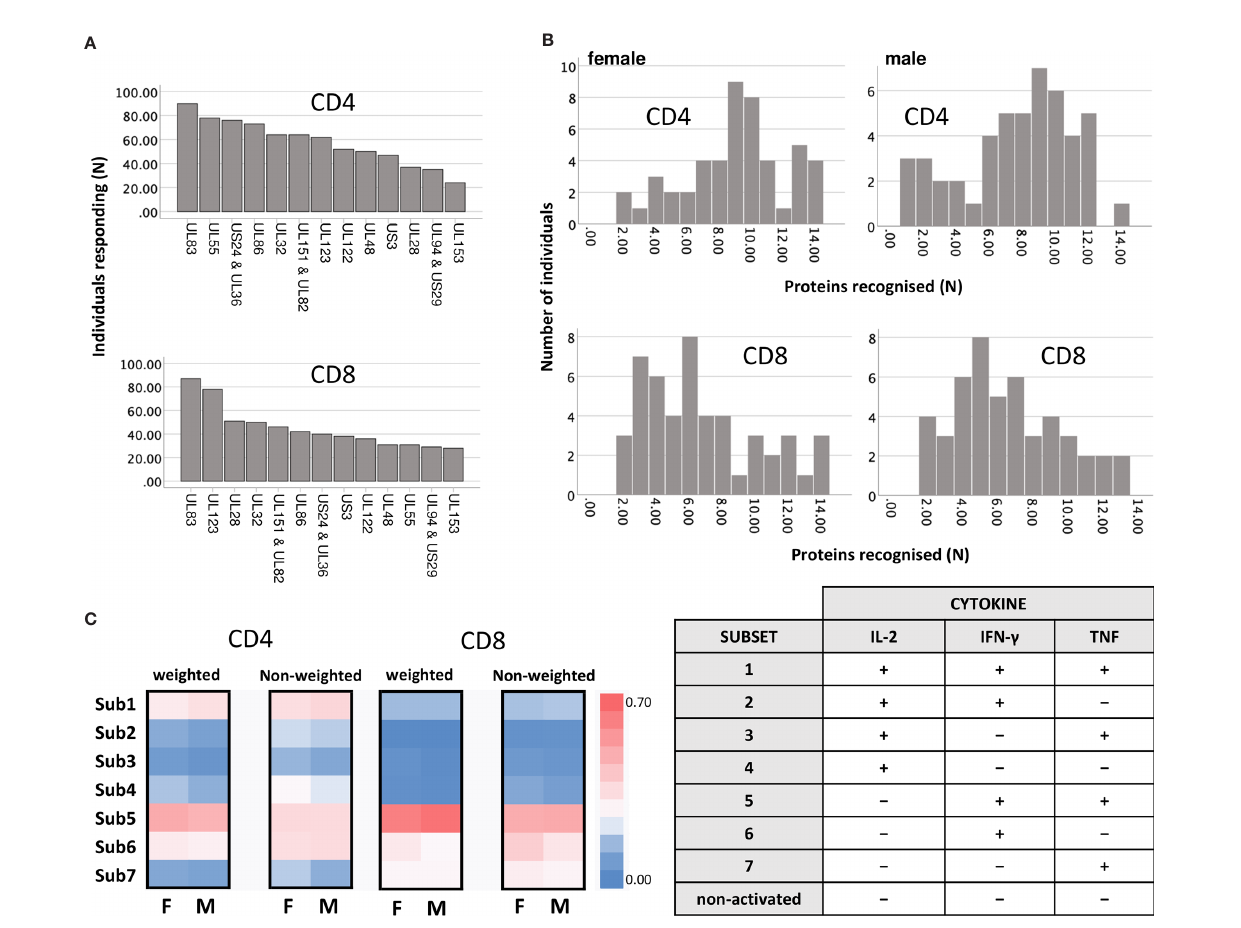
FIGURE 1 | Reactivity of CD4 and CD8 T-cells against dominant CMV proteins. (A) The indicated proteins (overlapping peptide pools) were used for PBMC stimulation. Responses (IL-2, TNF, or IFN- g ) equal to or higher than 0.01% (1/10,000) of the reference population (CD4 or CD8) were included. The graph shows the number of individuals recognising the indicated CMV protein pools within the entire cohort (n=94). (B) The graph shows the number of recognised proteins per individual (x-axis) in females (right panels, n=47) and males (left panels, n=47), respectively. (C) Heatmaps show the frequency distribution of functional Subsets 1 to 7 (respectively: IL-2+/TNF+/IFN- g +; IL-2+/TNF+/IFN- g -; IL-2+/TNF-/IFN- g +; IL-2+/TNF-/IFN- g -; IL-2-/TNF+/IFN- g +; IL-2-/TNF+/IFN- g -; and IL-2-/TNF-/IFN- g +, right table) within CD4 and CD8 T-cells, in females and in males. The heatmaps on the left show the contribution of each subset after weighing this relatively to the overall response size, while the heatmaps on the right show the unweighted contribution (not normalised for the response